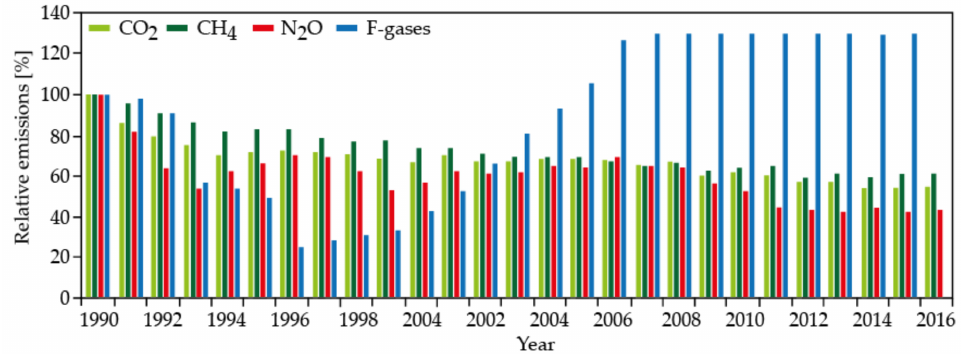
Figure 9. Trends of individual emissions according to the 1990 level